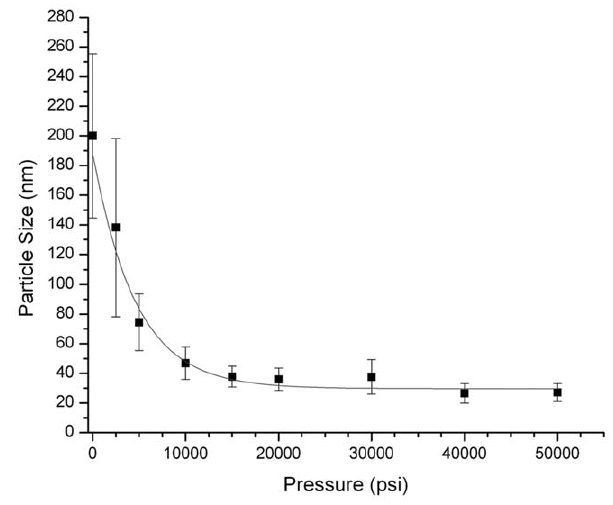
Figure 5. Effect of elevated pressure on aggregate size. Lysozyme tissue surrogates were incubated in 50 mM Tris-HCl buffer, pH 4 with 2% SDS and 0.1 M glycine at100 u C for 2 h at pressures ranging from atmospheric pressure (14.7 psi) to50,000 psi. The average particle size of the solubilized protein was measured by dynamic light scattering to determine the degree of protein aggregation.